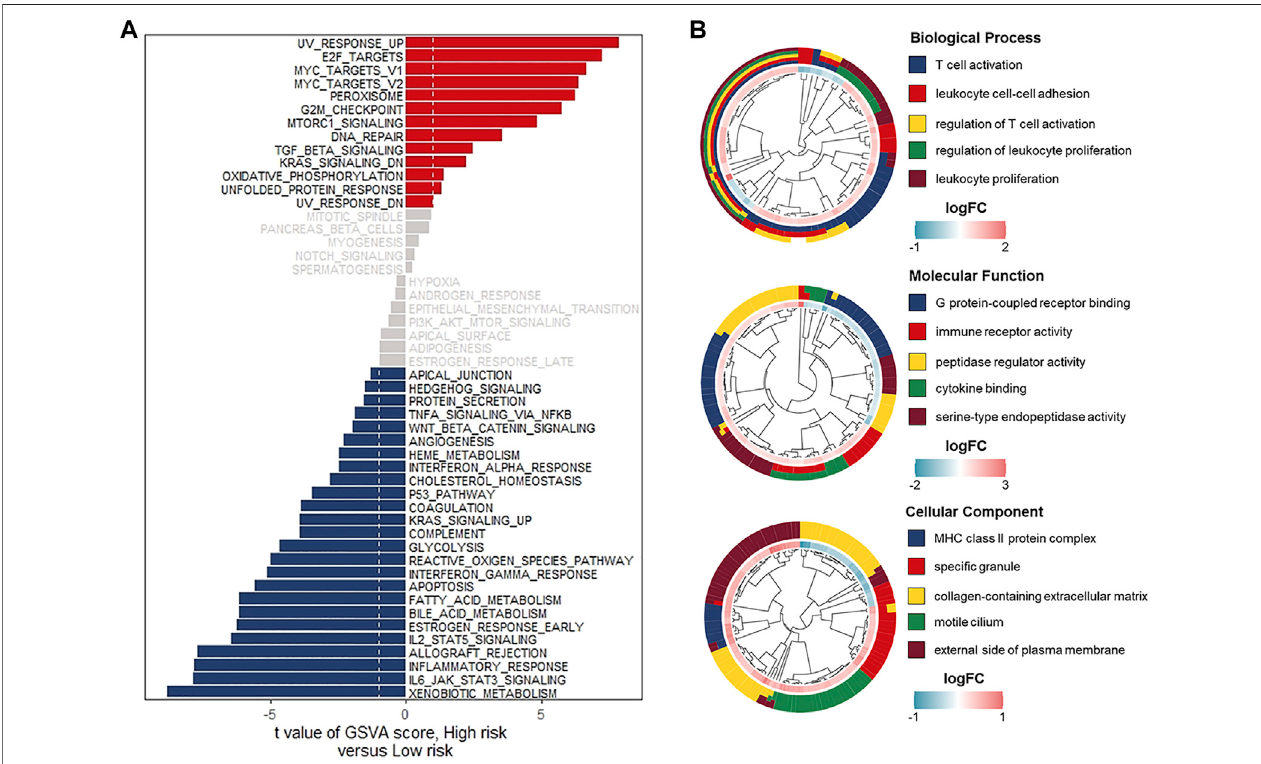
FIGURE 6 | Comprehensive analyses of enriched pathways in different risk groups. (A) GSVA enrichment analyses in the low- and high-risk groups indicating the activated biological pathways. (B) GO terms analyses of 504 risk-related DEGs. Biological process (upper), Molecular function (middle), Cellular component (bottom).